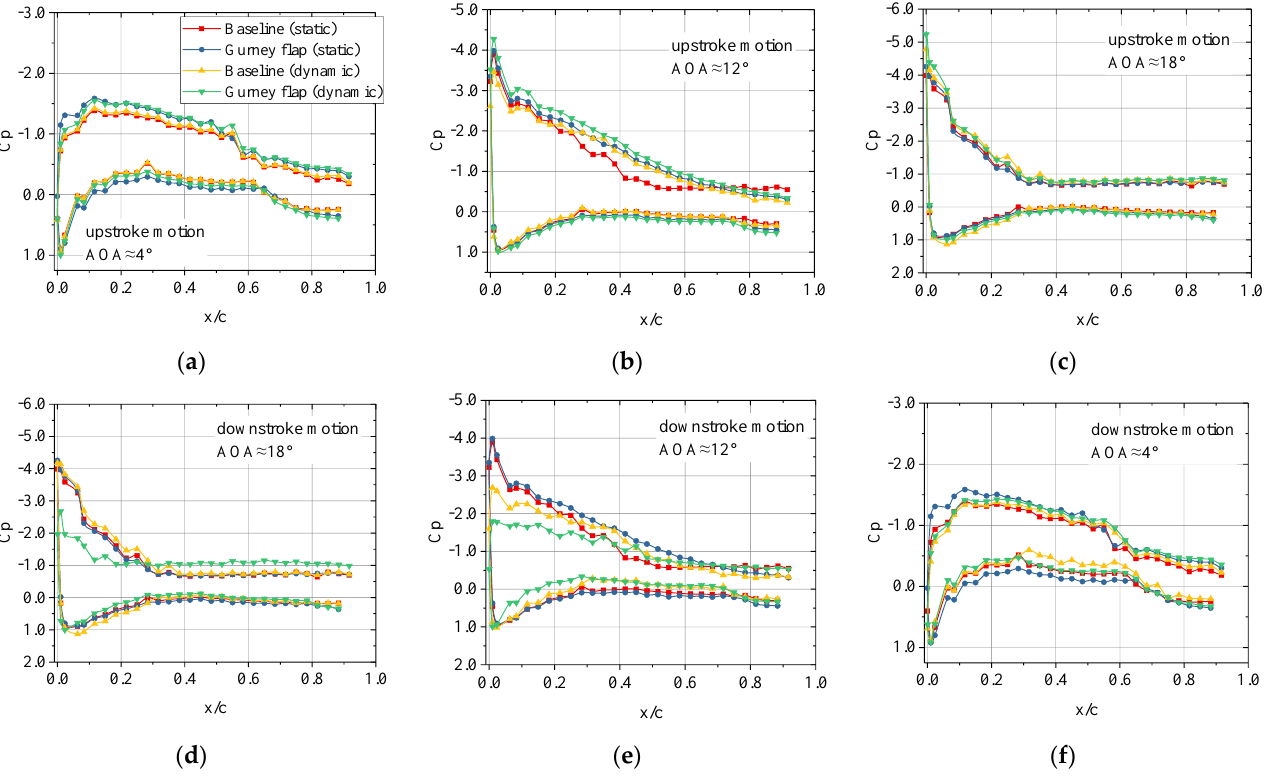
Figure 6. Comparison of the pressure coefficient measured for A = 10, α mean = 10 and K = 0.0167 in a period at the uniform inflow. ( a ) upstroke, AOA ≈ 4°; ( b ) upstroke, AOA ≈ 12°; ( c ) upstroke, AOA ≈ 18°; ( d ) downstroke, AOA ≈ 18°; ( e ) downstroke, AOA ≈ 12°; ( f ) downstroke, AOA ≈ 4°.